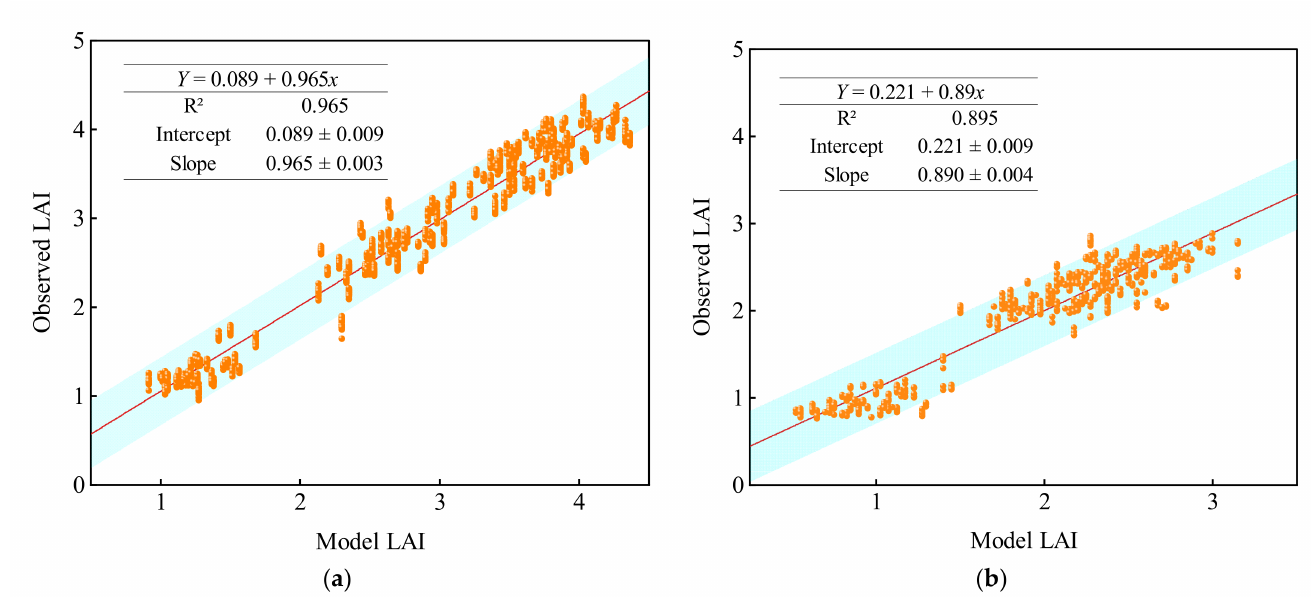
Figure 8. Estimation results of maize LAI by secondary models (MLR) in ( a ) 2020 and ( b )